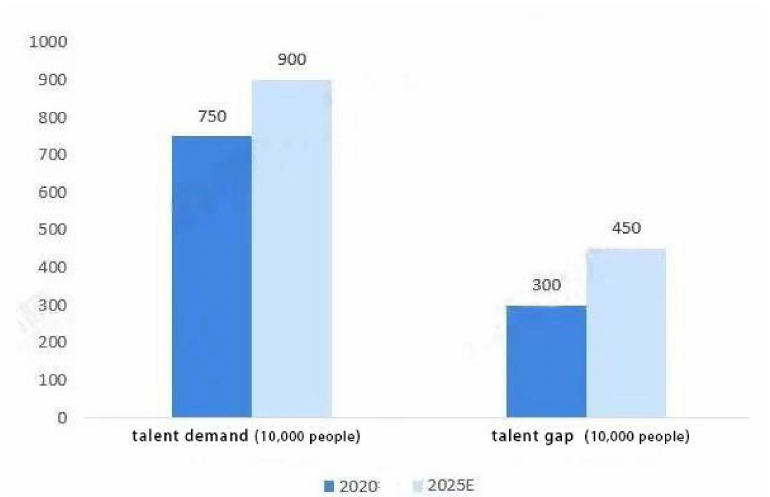
Figure 3. Talent demand and talent gap in intelligent manufacturing field in China; unit: 10,000 per- sons (Source: China Ministry of Human Resource and Social